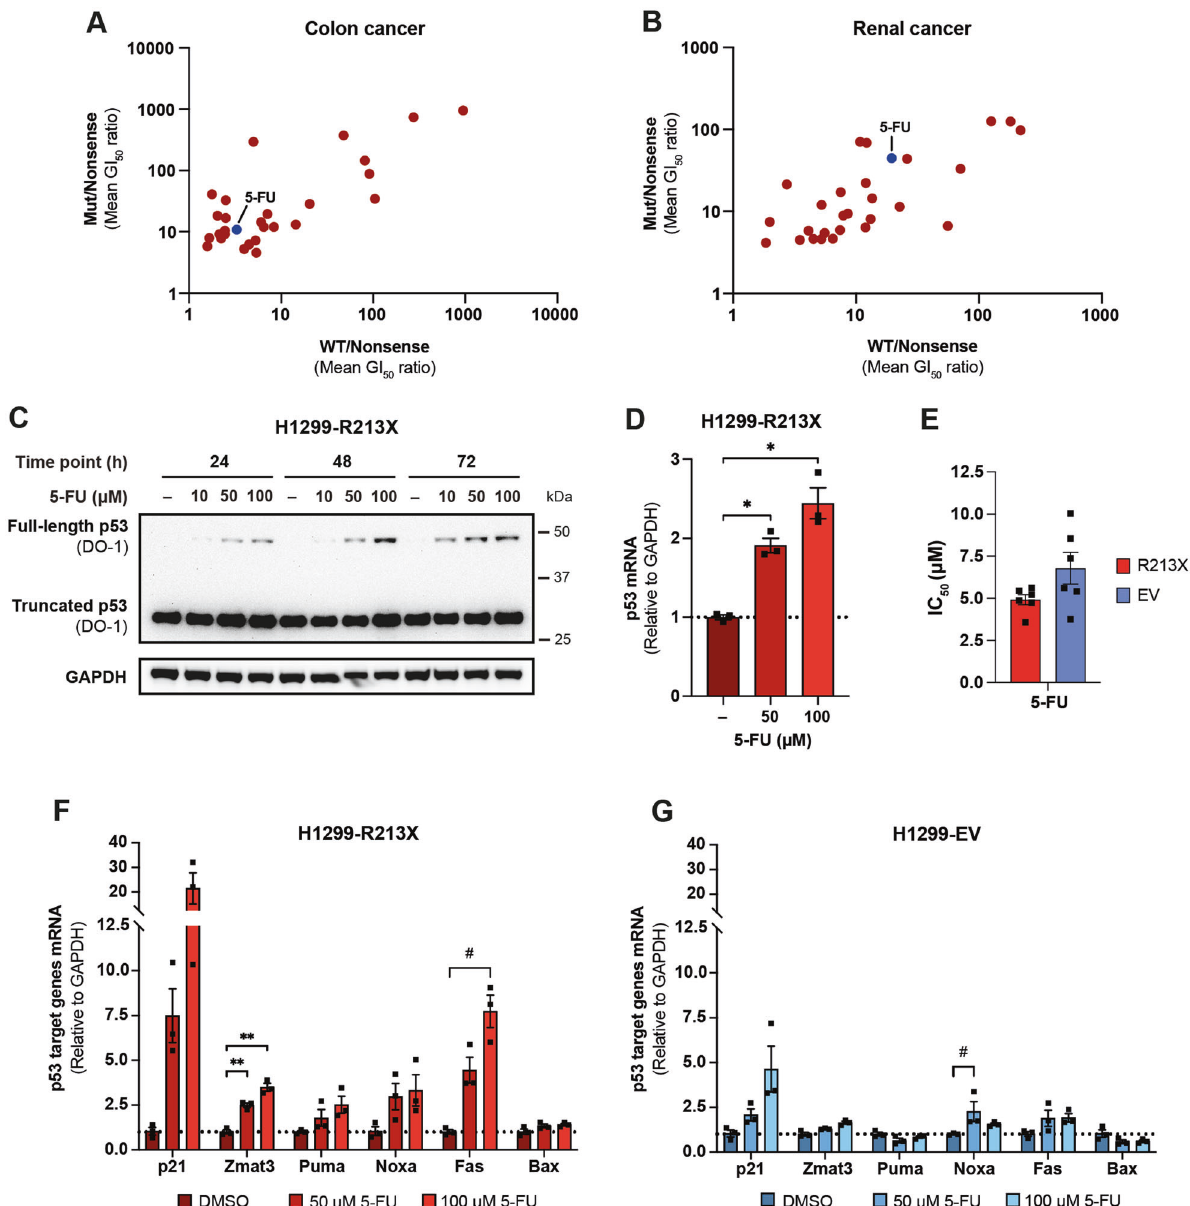
Fig. 1 5-FU induces full-length and transcriptionally active p53. Ratios of mean 50% growth-inhibitory concentrations (GI 50 ) for 28 top hit compounds between cancer cell lines carrying other TP53 mutations and cancer cell lines carrying nonsense TP53 mutations shown on the y-axis (Mut/Nonsense), and between cancer cell lines carrying WT TP53 and cancer cell lines carrying nonsense TP53 mutations shown on the x-axis (WT/Nonsense) in colon cancer cell lines (A) and renal cancer cell lines (B) . Each dot represents one compound. C , Full-length p53 induction by 5-FU in H1299-R213X cells is dose-dependent after 24, 48 or 72 h treatment, according to Western blotting with p53 antibody DO-1. GAPDH was used as loading control and DMSO (-) was used as negative control. Full membrane was blotted with DO-1 antibody, washed and blotted with GAPDH antibody. D , qRT-PCR analysis showing induction of p53 mRNA levels after 50 or 100 µM 5-FU treatment for 72 h in H1299-R213X cells, N = 3. DMSO (-) was used as negative control. E , IC 50 (µM) values of 5-FU treatment for 72 h in H1299-R213X and H1299-EV cells, N = 6. F , mRNA levels of p53 target genes p21, Zmat3, Puma, Noxa, Fas and Bax after 50 or 100 µM 5-FU treatment for 72 h measured by qRT-PCR in H1299-R213X cells and G , H1299-EV cells, N = 3. In D , F and G , expression of some genes was examined simultaneously in each cell line with a single GAPDH control; thus, same GAPDH value was used as control for several genes. Gene expression values were normalized to GAPDH expression and to the DMSO-treated sample as negative control. Statistical analyses for each gene were performed comparing each treatment to DMSO control treatment using repeated measures one-way ANOVA followed by Dunnett ’ s multiple comparisons test (* p ≤ 0.05, ** p ≤ 0.01) or Friedman test followed by Dunn ’ s multiple comparisons test ( # p ≤ 0.05) in genes with data not fi tting normal distribution. In D , E , F and G , data are represented as mean ± SEM. Each dot represents an independent Ribosome pro fi ling supports induction of translational readthrough by FUr To investigate FUr-induced translational readthrough of R213X mutant TP53 at nucleotide resolution, we performed Ribo-seq